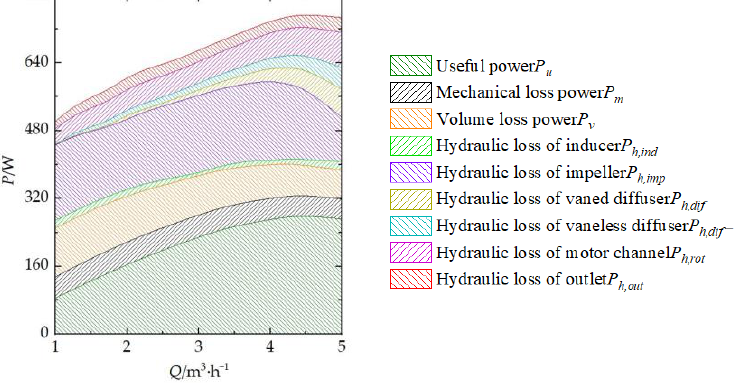
Figure 8. Relationship between various lost power and flow.